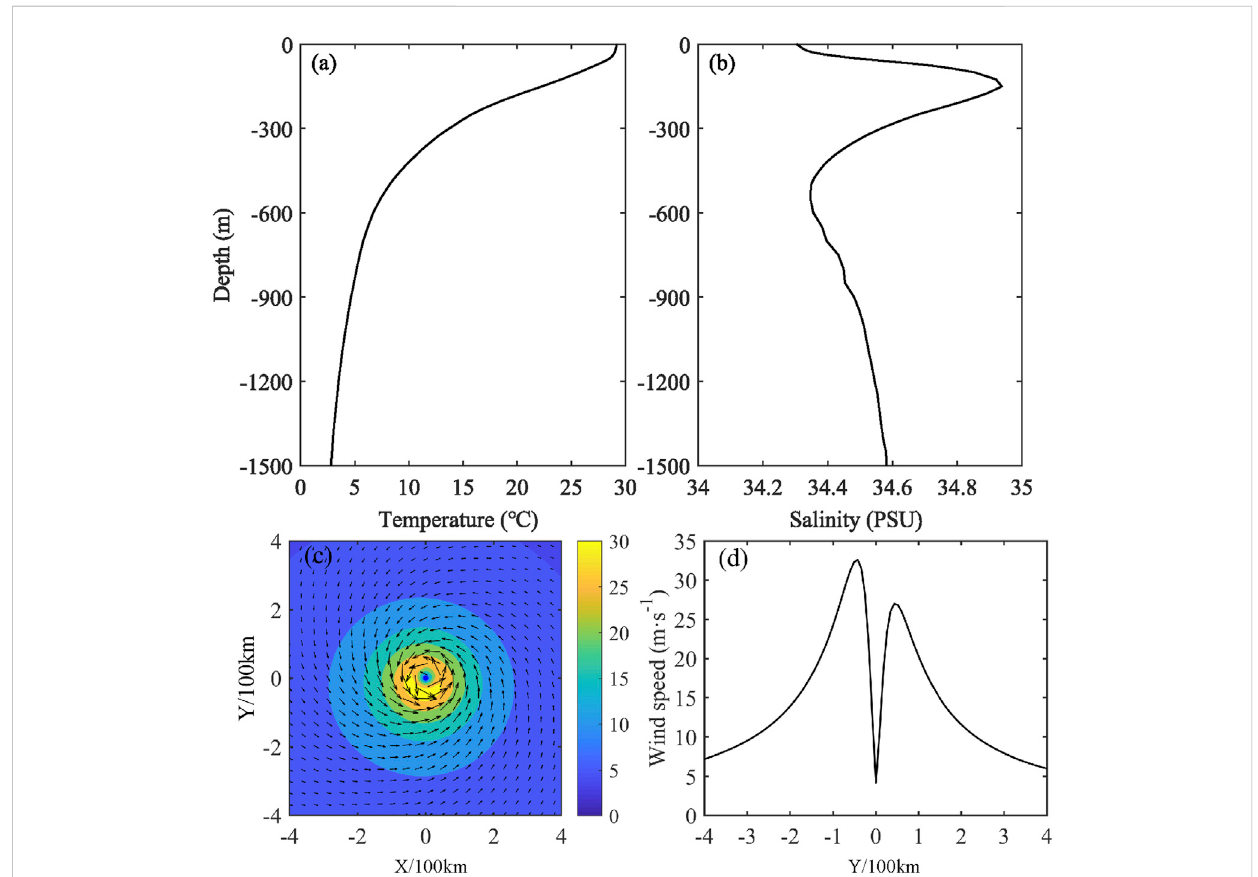
FIGURE 2 (A) Temperature and (B) Salinity for the WOA18 pro fi les averaged over the domain of 130 ° – 180 ° E, 10 ° -25 ° N during the TC season (from August to October). These were used as initial conditions for CROCO model. (C) The reconstructed vector wind fi eld of idealized TC based on the SLOSH method, with color shading for wind speed. (D) Idealized wind speed across TC center and along the y